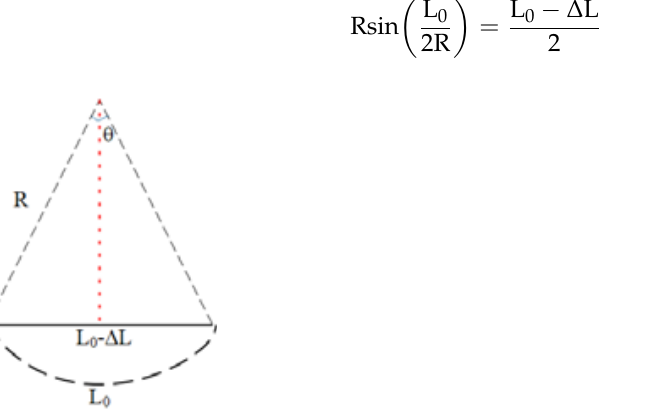
Figure 10. Schematic diagram of curvature change of the sensor.